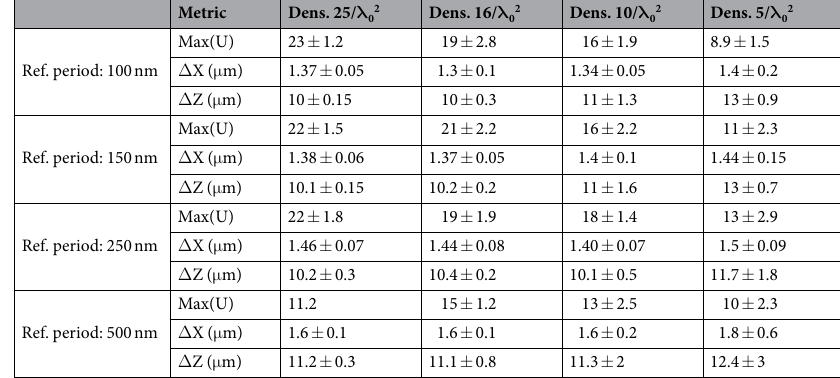
Table 1. Summary of the performances of the 1D random metasurfaces with the mean maximum density of energy, width and length of the focal spots, with their standard